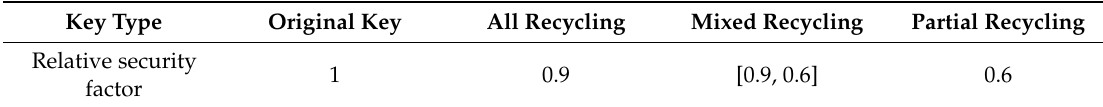
Table 3. Relative Security Factor of the